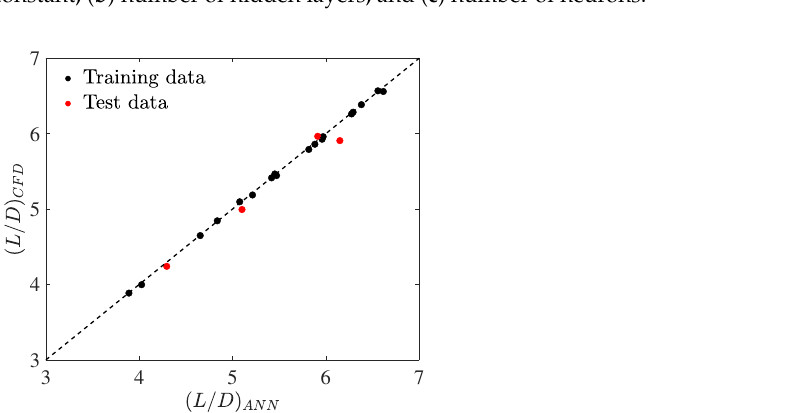
Figure 13. The accuracy of the ANN in predicting the CFD-computed lift-to-drag ratio. The black dots are the 19 data sets used to train the ANN, while the red dots are four test data sets used to measure the ANN’s accuracy. The R-squared values of the training data sets and test data sets with a 45 ◦ line are 0.9992 and 0.9643,